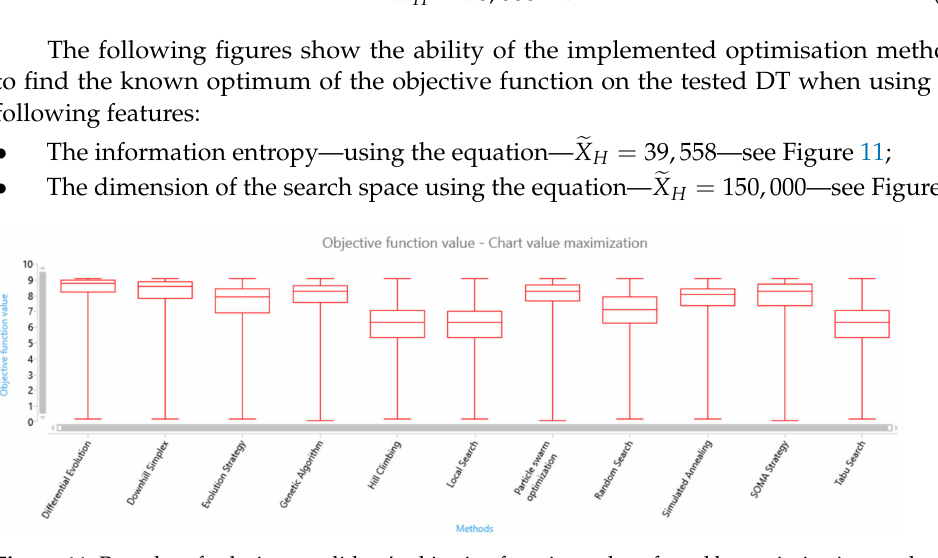
Figure 11. Box plot of solution candidate’s objective function values found by optimisation methods— the second termination criterion using information